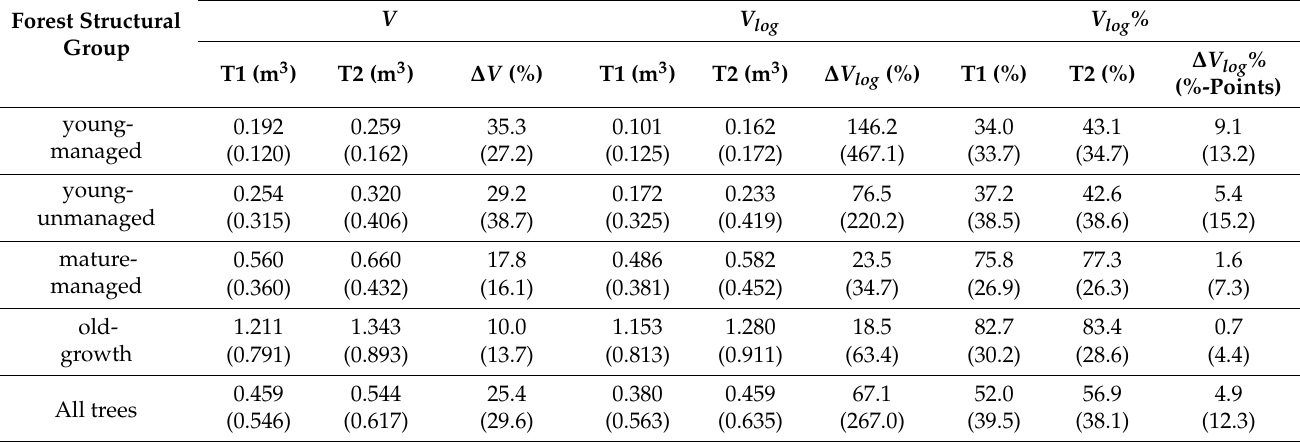
Table 4. Means and standard deviations (std.) of the estimated attributes characterizing stem volume allocation at the beginning (2014, T1) and at the end of the monitoring period (2019, T2) as well as their change ( ∆ ) for trees in different forest structural groups as well as for all trees used in this study. Stem volume ( V ) and logwood volume ( V log ) are reported in m 3 whereas logwood percentage ( V kog % ) is presented in % in the table. Relative change in stem volume ( ∆ V ) and relative change in logwood volume ( ∆ V log ) are presented in percentages whereas change in logwood percentage ( ∆ V log % ) is reported in percentage